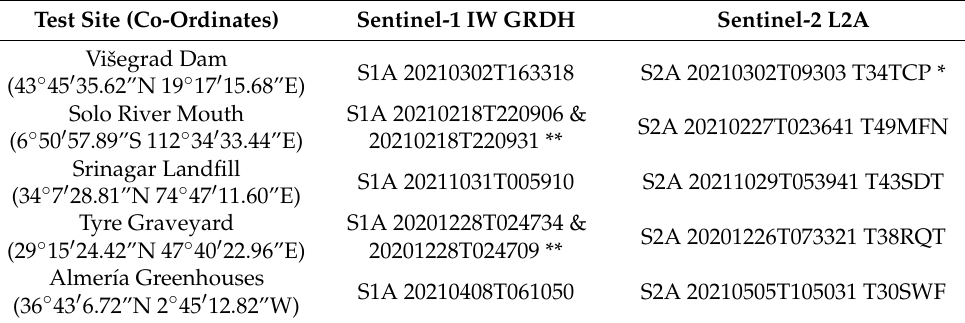
Table 1. Test site locations with Sentinel-1 IW GRDH and Sentinel-2 Level 2A files as date/time and (for Sentinel-2) tile. Test Site